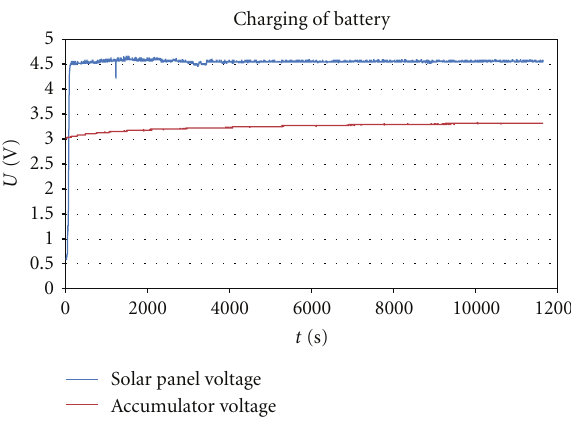
Figure 8: Charging of 2600 mAh battery capacity.